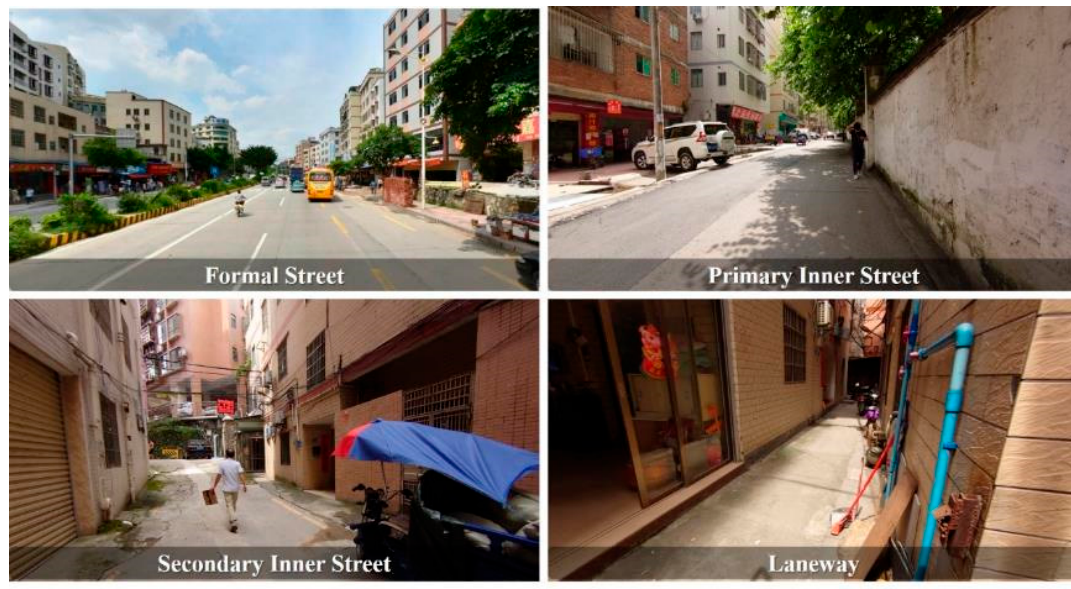
Figure 4. Photos of di ff erent types of streets.